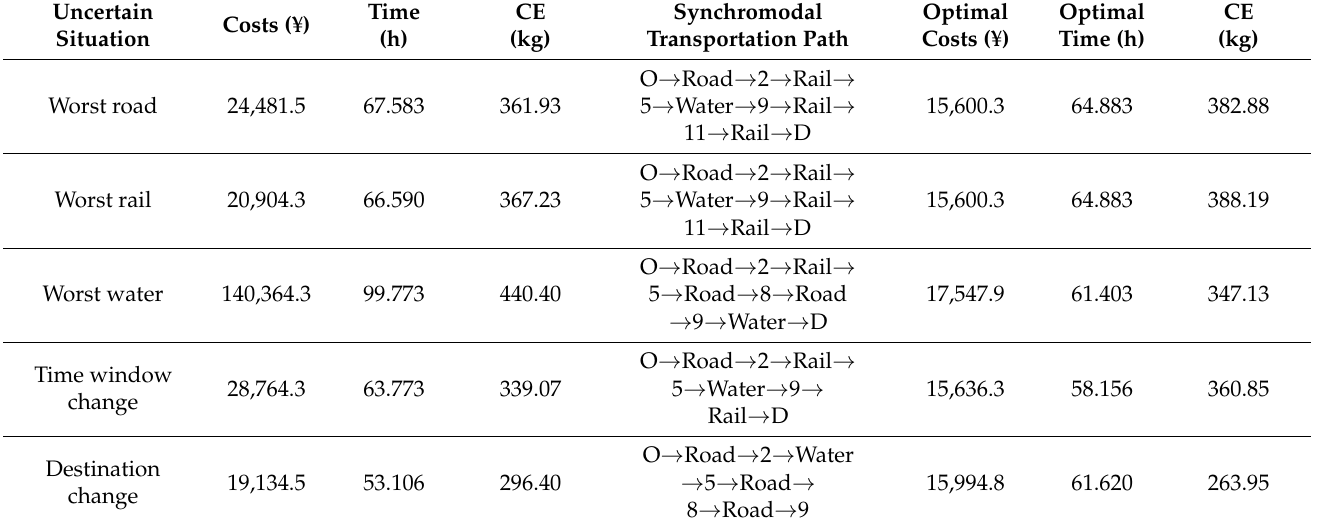
Table 5. Optimal transportation paths considering ST under